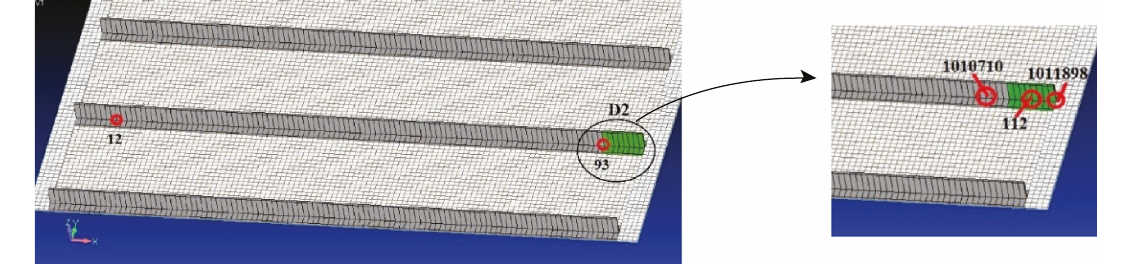
Figure 17: Excitation and measuring nodes for D2 damage along the second sti ff ener.